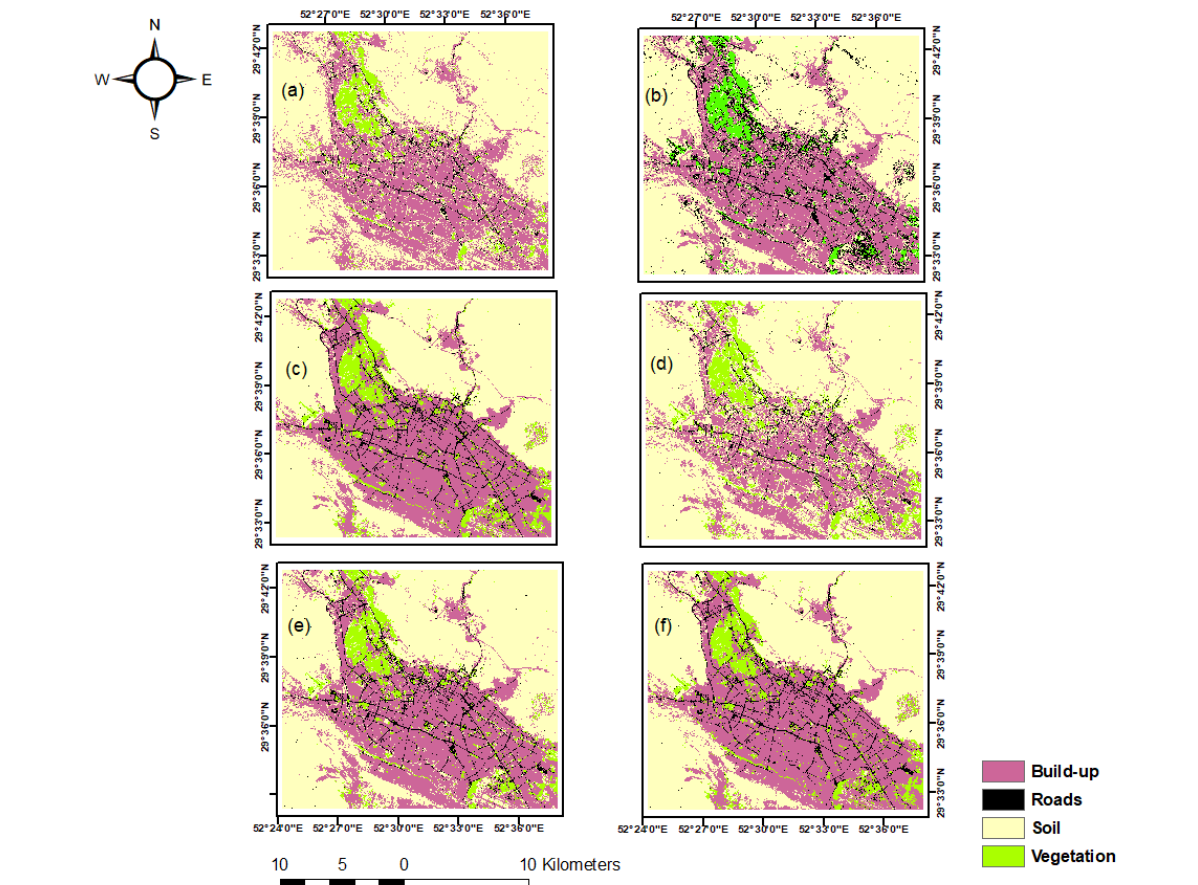
Figure 4. Results of classification algorithms including a) Decision Table b) DTNB c) Multilayer Perceptron d) NN ge e) Random Forest f) Simple